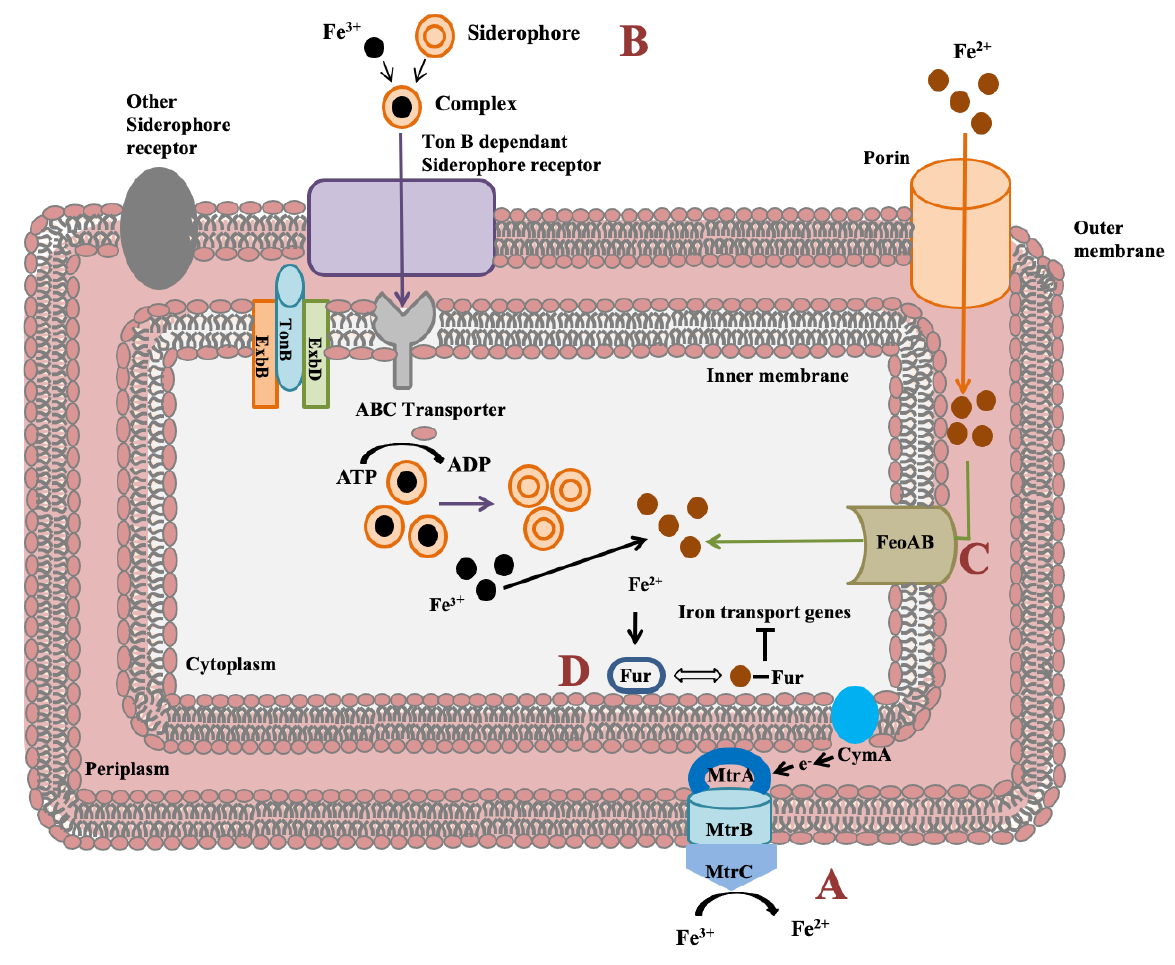
Figure 7. Iron uptake genes in Shewanella sp. N2AIL and their route. ( A ) The c-type cytochrome encoded by mtrABC cluster spanning outer membrane responsible for reduction of soluble ferrous form (Fe 2+ ) to insoluble ferric form (Fe 3+ ). ( B ) Fe 3+ in the environment can be reduced to Fe 2+ by siderophore-mediated iron uptake system via Ton B dependant receptor of Shewanella sp. N2AIL for uptake of Fe 3+ -Siderophore complexes and transported by ABC transporter to cytoplasm where Fe 3+ is reduced to Fe 2+ and released from the complex. ( C ) Another strategy employed is FeoAB system, a ferrous iron transporter for uptake of Fe 2+ across inner membrane. ( D ) A global ferric uptake regulator encoded by fur gene control bacterial iron homeostasis.